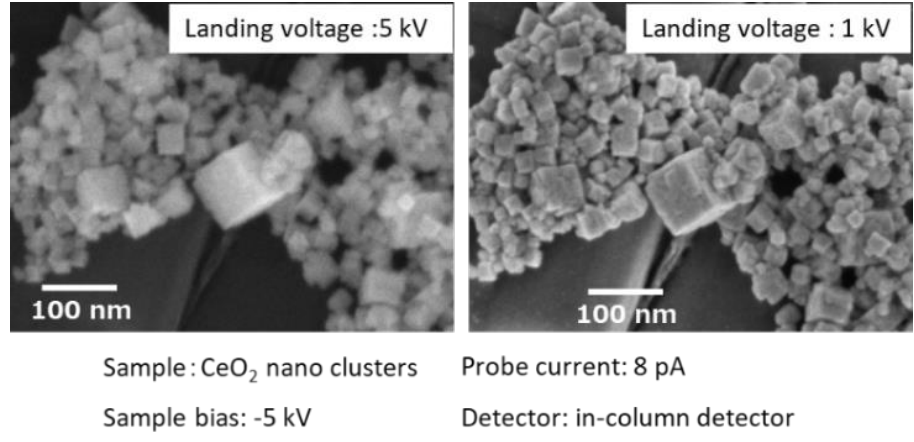
Figure 1. SEM images of CeO 2 nanoclusters with different electron landing